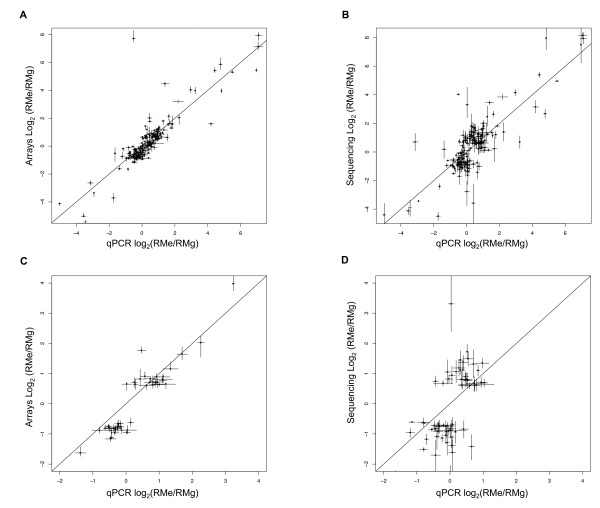
Quantitative PCR of significantly differentially expressed genes show better agreement with arrays than sequencing. 192 randomly sampled significantly differently expressed genes were analyzed by qPCR. qPCR results are highly correlated with both microarrays (R = 0.86, bootstrap 95% CI: 0.7043 – 0.953) (A) and sequencing results (R = .82, bootstrap 95% CI: 0.7031 – 0.8917) (B). However, the subset of the tested genes that were called significantly differentially expressed by the arrays only (see Fig. 1A, red dots) were more highly correlated (R = 0.925, bootstrap 95% CI: 0.8621 – 0.9648) (C) than the subset of genes that were called significant by sequencing (see Fig. 1A, green) (R = 0.518, bootstrap 95% CI: 0.3227 – 0.7069) (D). Error bars represent 95% confidence intervals for the differential expression measurements.